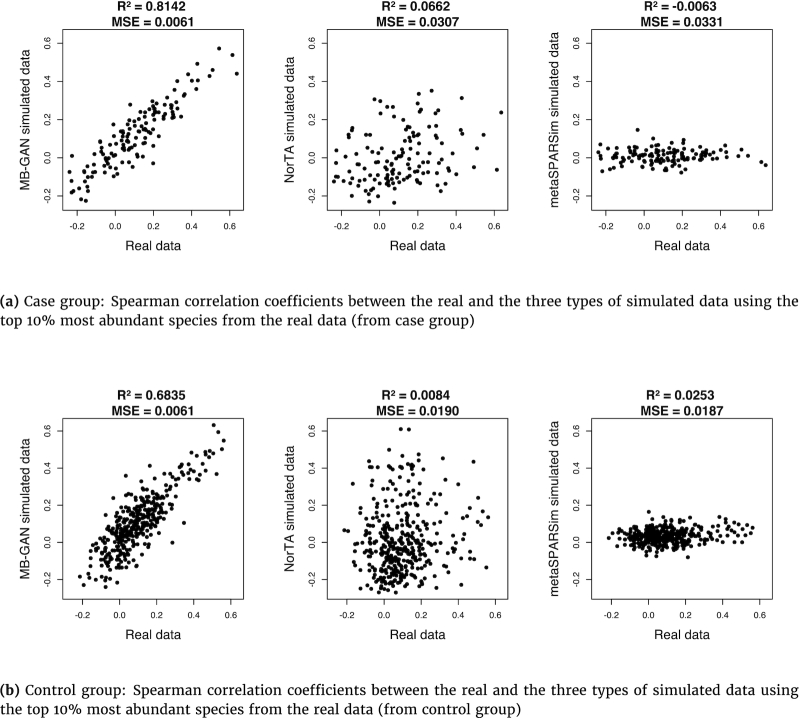
Scatter plot of the Spearman correlation coefficients between the real and the simulated data by MB-GAN, Normal-To-Anything (NorTA), and metaSPARSim. Results are calculated based on the top 10% most abundant species from the real data of the (a) case and the (b) control group.